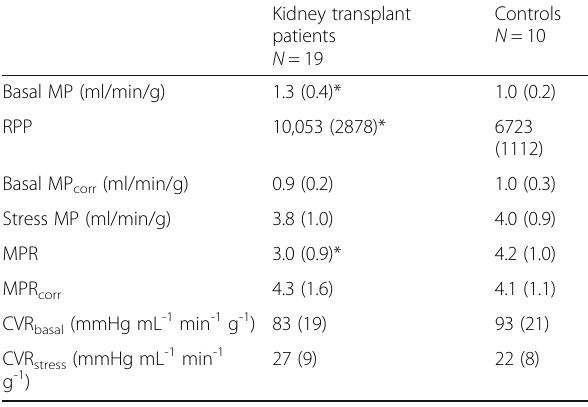
Table 3 Myocardial flow values in all subjects